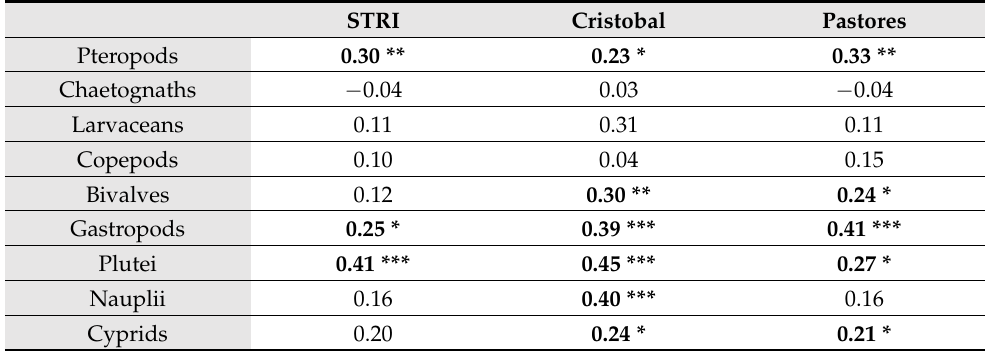
Table 1. Kendall Tau correlation coefficient between log(x + 1) transformed abundances at 11 m and 21 m. Asterisks denote p -values: * < 0.05; ** < 0.01; *** < 0.001. All correlation coefficients with a p -value < 0.05 are in bold .